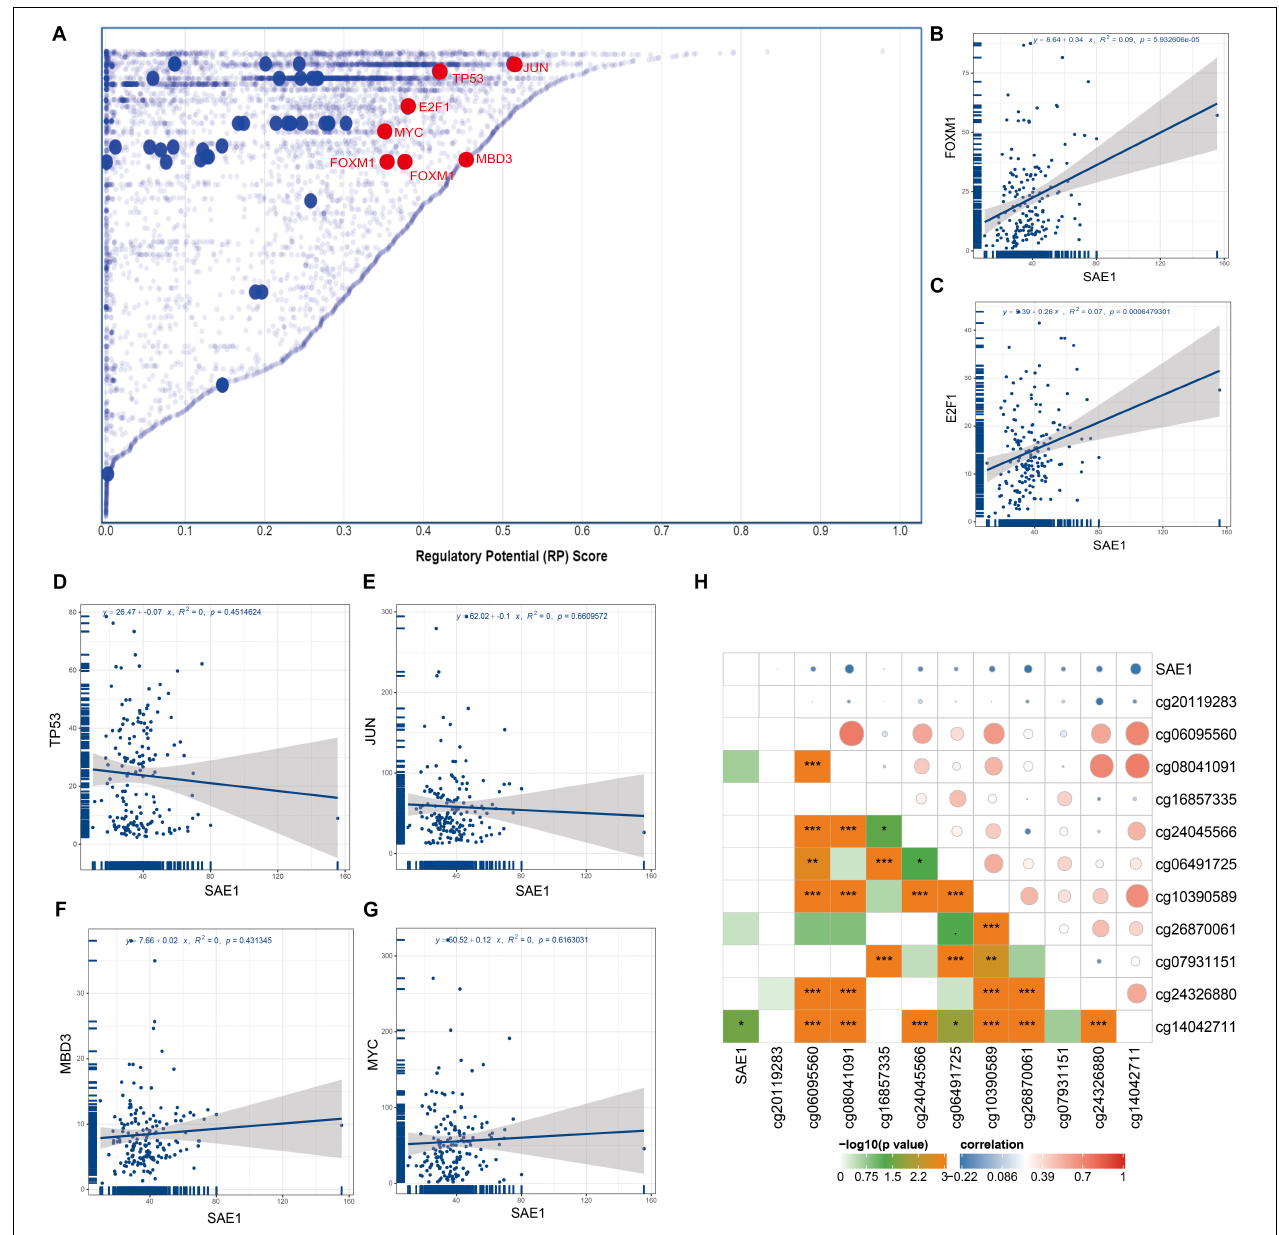
FIGURE 3 | Relationships of SAE1 with TFs and DNA methylation. (A) TFs with high regulatory potential in MDA-MB-231 cell lines (10k distance to TSS). (B) Correlation between SAE1 and FOXM1 mRNA expression. (C) Correlation between SAE1 and E2F1 mRNA expression. (D) Correlation between SAE1 and TP53 mRNA expression. (E) Correlation between SAE1 and JUN mRNA expression. (F) Correlation between SAE1 and MBD3 mRNA expression. (G) Correlation between SAE1 and MYC mRNA expression. (H) Relationships of SAE1 with DNA methylation in TNBC. * p < 0.05; ** p < 0.01; *** p <